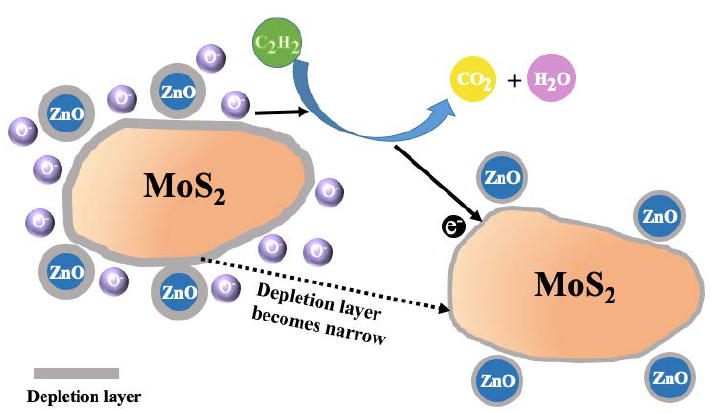
Figure 15. Schematic diagrams of surface sensing reaction of the ZnO-MoS 2 nanocomposites sensor exposure C 2 H 2 gas.